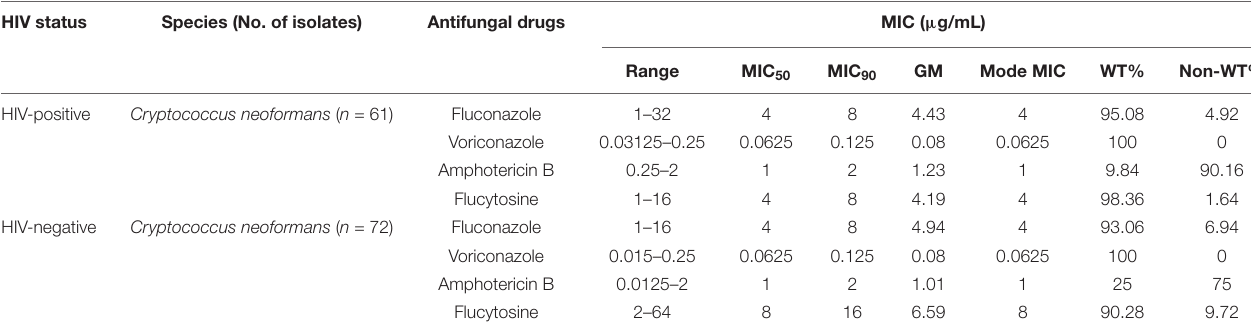
TABLE 1 | In vitro susceptibilities of Cryptococcus neoformans in HIV-positive and HIV-negative cryptococcosis patients. HIV status